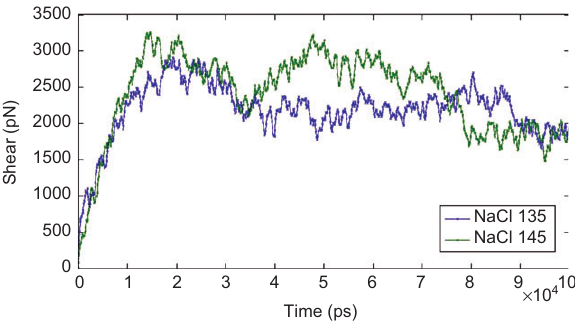
Figure 6 Stress-strain graphs for two axial tropological molecules under different NaCl concentrations.